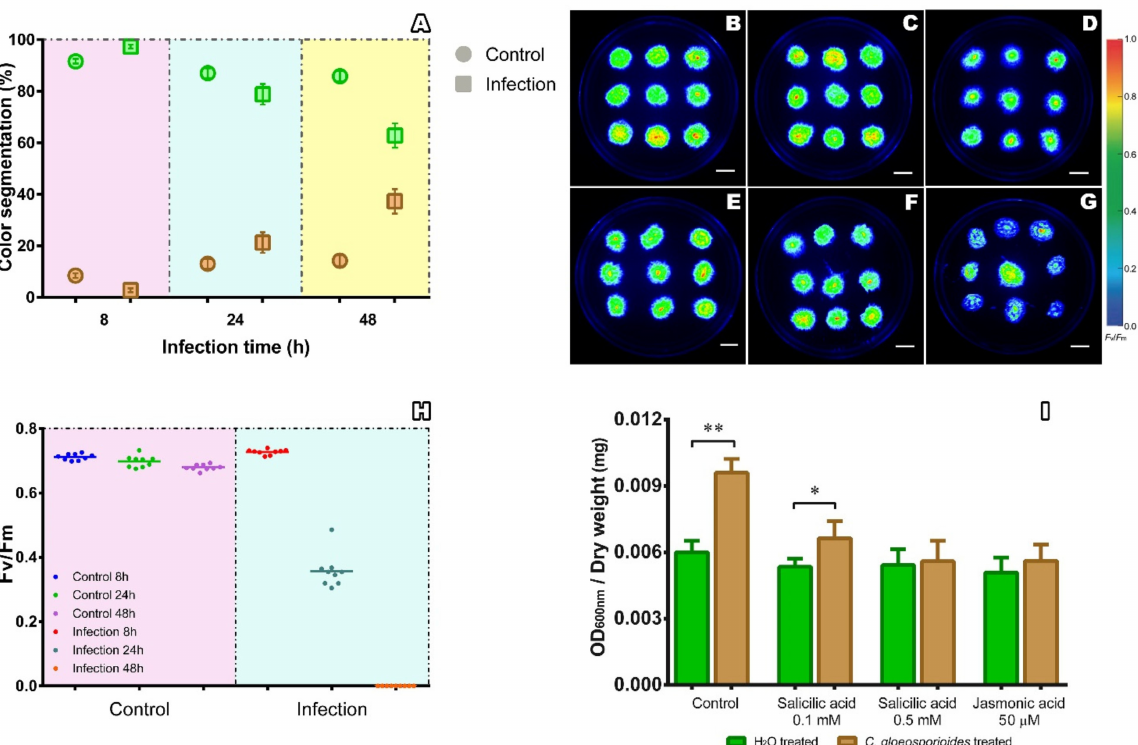
Figure 2. Phenomics analysis of P. patens during its interaction with C. gloeosporioides . ( A ) Effect of the interaction between P. patens and C. gloeosporioides on the green and brown color segmentation. The circles represent the controls and the squares the infected samples. The green color represents the green tissue portion, and the brown color represents the brown tissue. Each point reflects the mean ( ± standard deviation) of three images with nine colonies each ( n = 27). ( B – G ) Fluorescent images of the moss colonies: ( B – D ) control without inoculation, at 8 hai, 24 hai and 48 hai, respectively; ( E – G ) infected colonies at 8 hai, 24 hai and 48 hai, respectively. Bars: 1 cm. ( H ) Mean of the quantum yield of Photosystem II ( ± standard deviation) of the P. patens colonies: control without inoculation (left panel) and infected samples (right panel). ( I ) Measurement of cell damage by Evans blue staining at 72 hai of colonies previously treated with hormones. Control plants had no hormone treatment before the C. gloeosporioides inoculation. The data are expressed as the optical density (OD) at 600 nm per milligram dry weight. The values in the graph are the means ( ± standard deviation) of eight independent replicas of the moss, and the asterisks on the bars indicate statistically significant differences ( p ≤ 0.01; n =